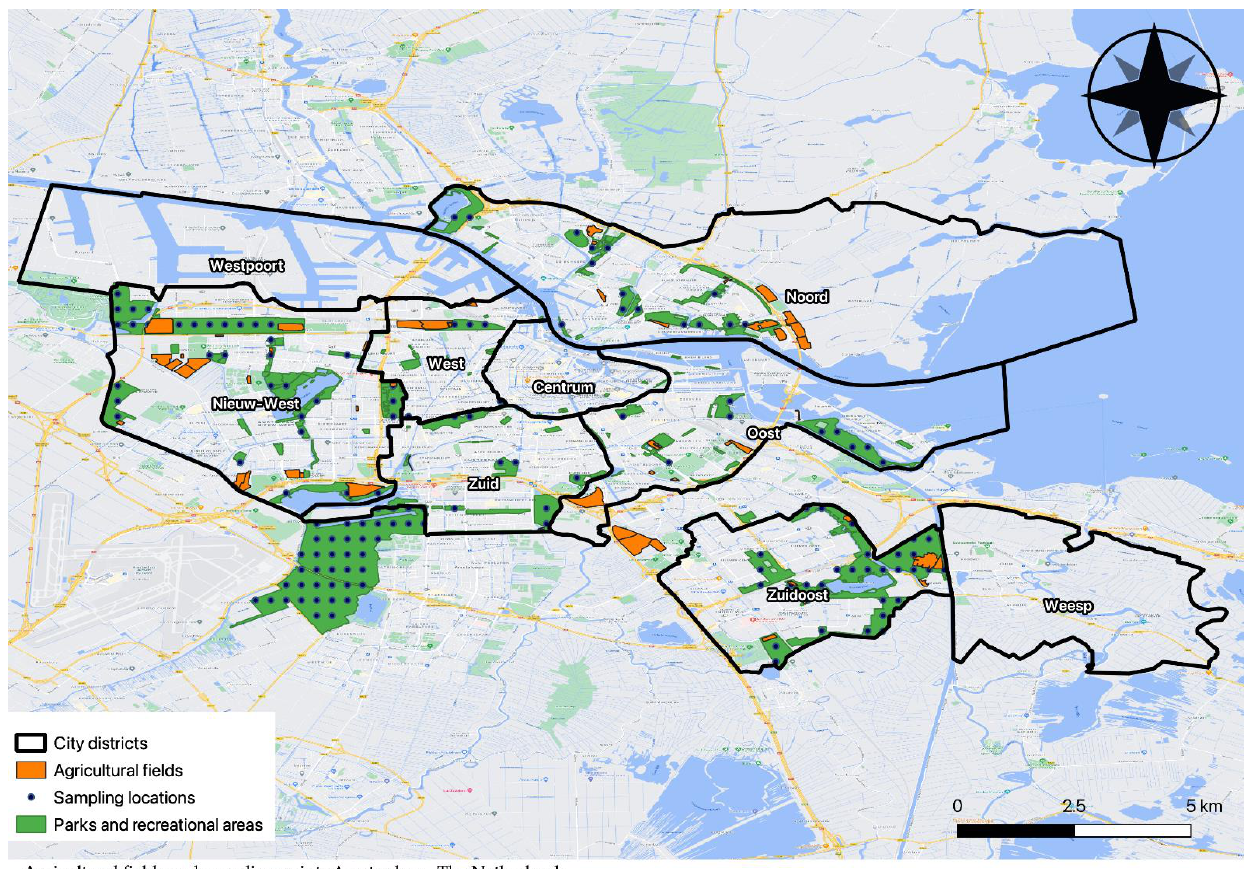
Figure 1. Sampling points in parks and recreational areas in Amsterdam, the Netherlands.